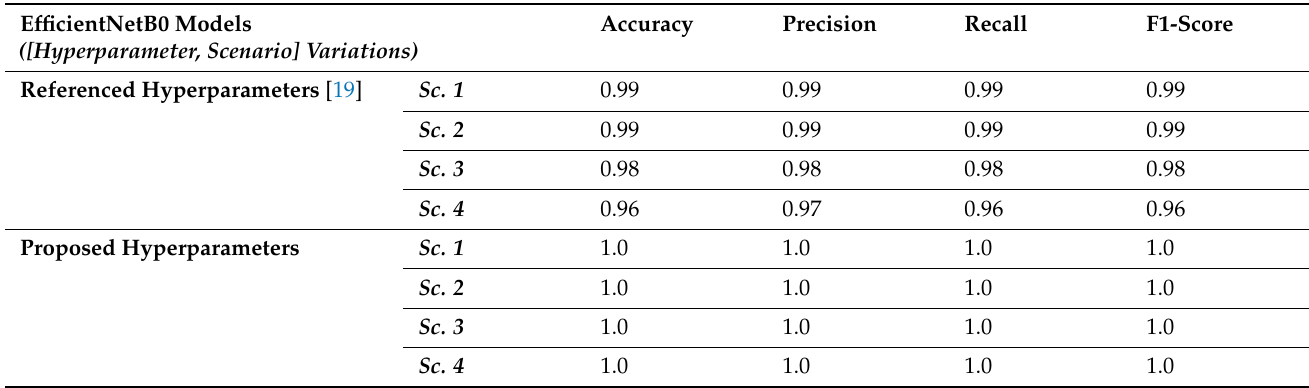
Table 4. Evaluation scores for developed EfficientNetB0